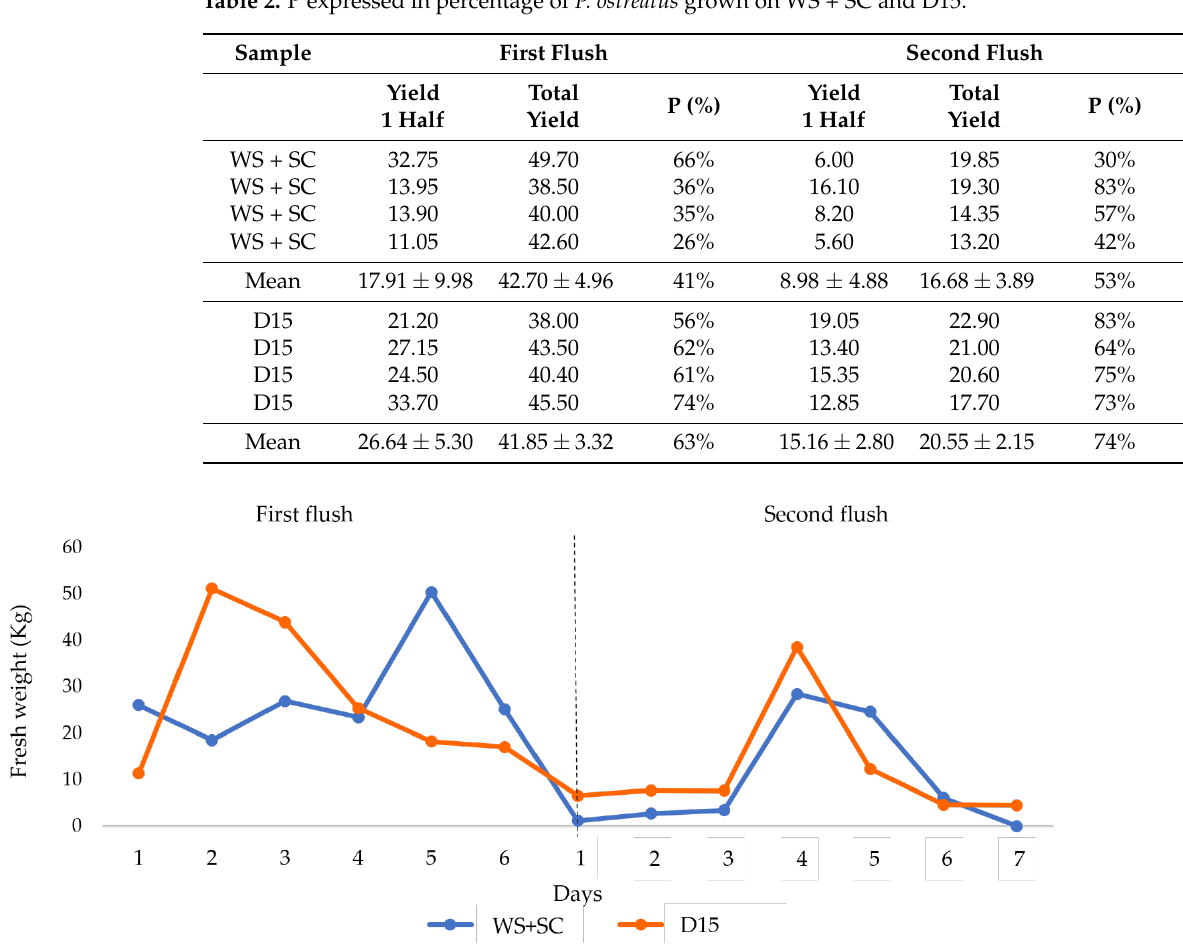
Figure 6. Yield trend of P. ostreatus grown on WS + SC (blue line) and D15 (orange line), expressed as total fresh weight per day in the first and second flushes.